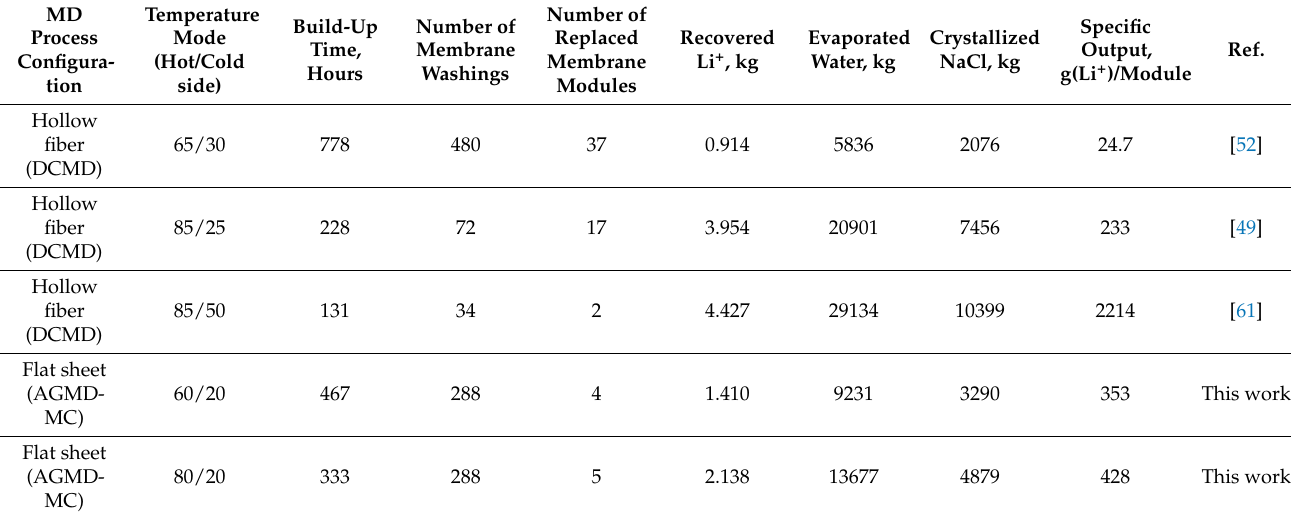
Table 7. Comparison of different configurations and performance of MD process reported in the literature and inthis work (two months of operation). Simulation conditions: RR = 50%, S = 2.5 m 2 , CF = 20, ER(Li + ) =